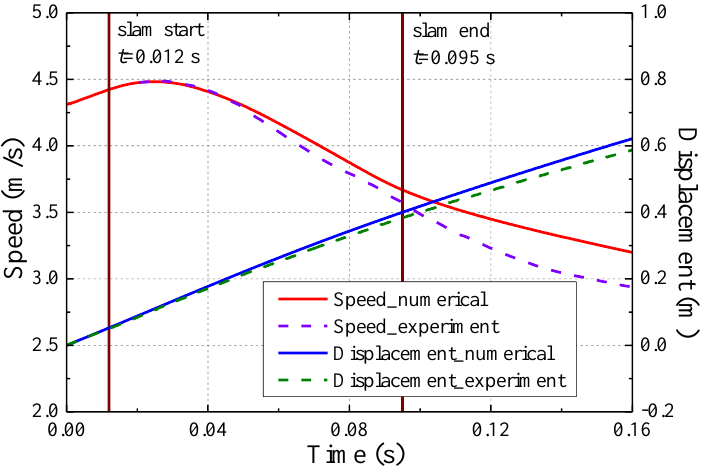
Figure 15. Comparison of vertical speed and displacement by simulation and experiment (Case 4).